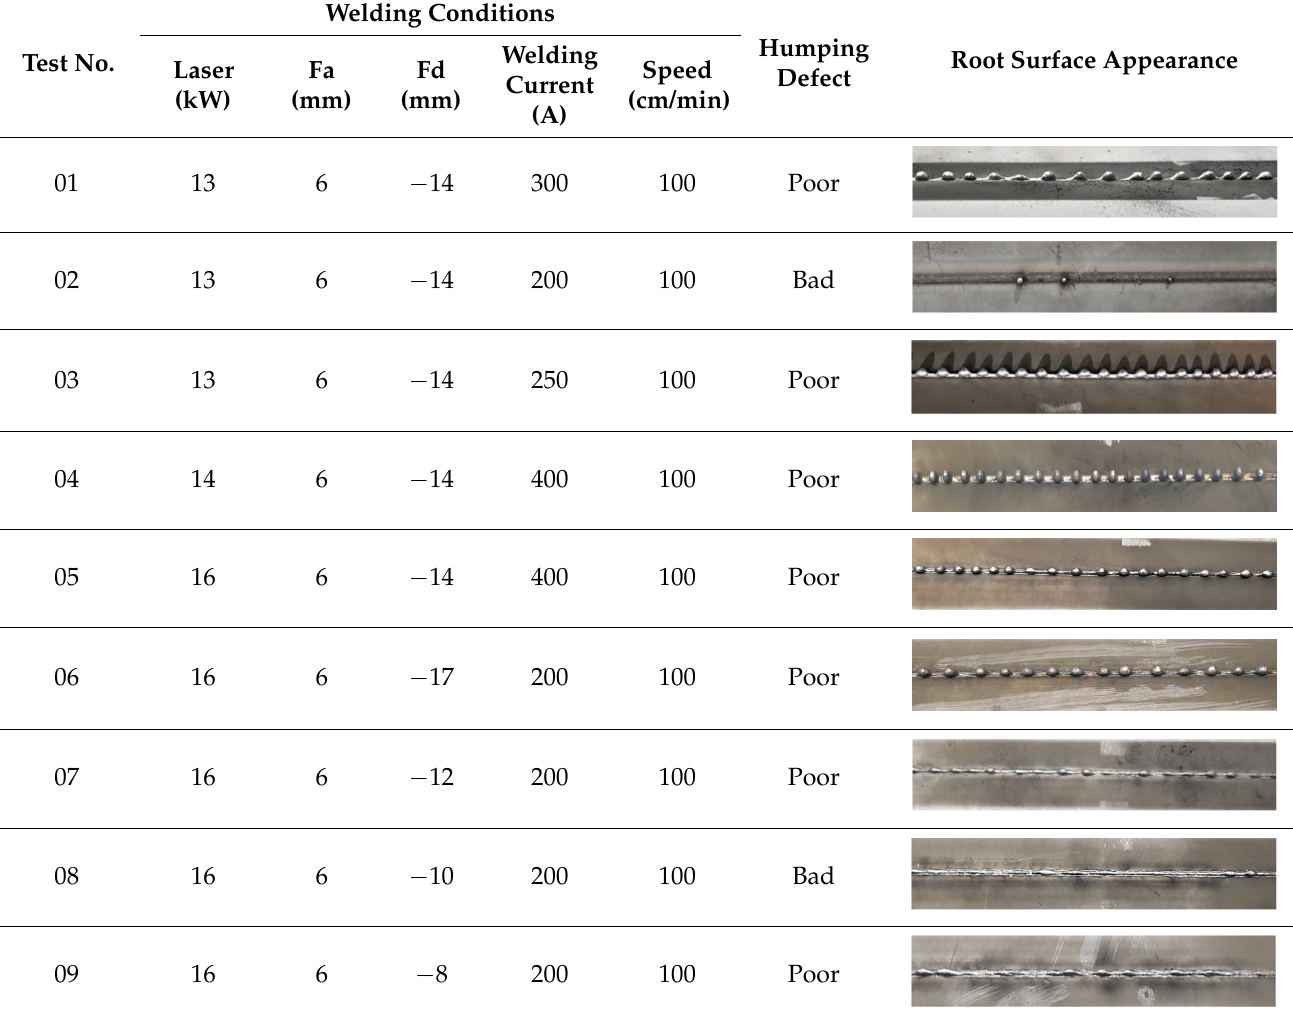
Table 4. Variation of the humping defect shape with the experimental conditions. Test No.